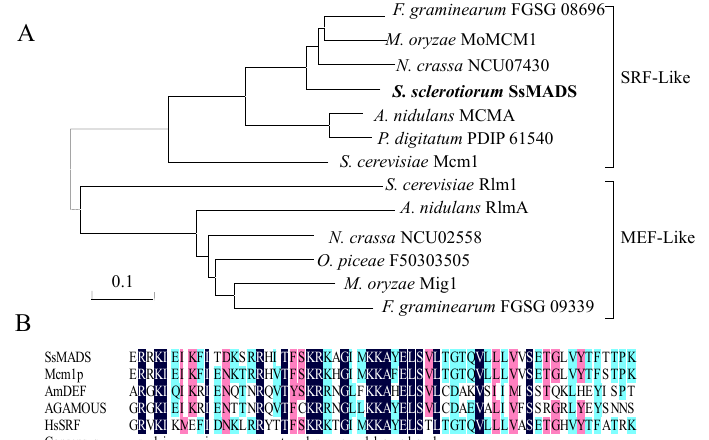
Figure 2. Restriction maps of the SsMADS RNAi vector. ( A ) Original pSilent-1 vector map [15]; ( B ) Two 520 bp fragments of the SsMADS gene were amplified from cDNA